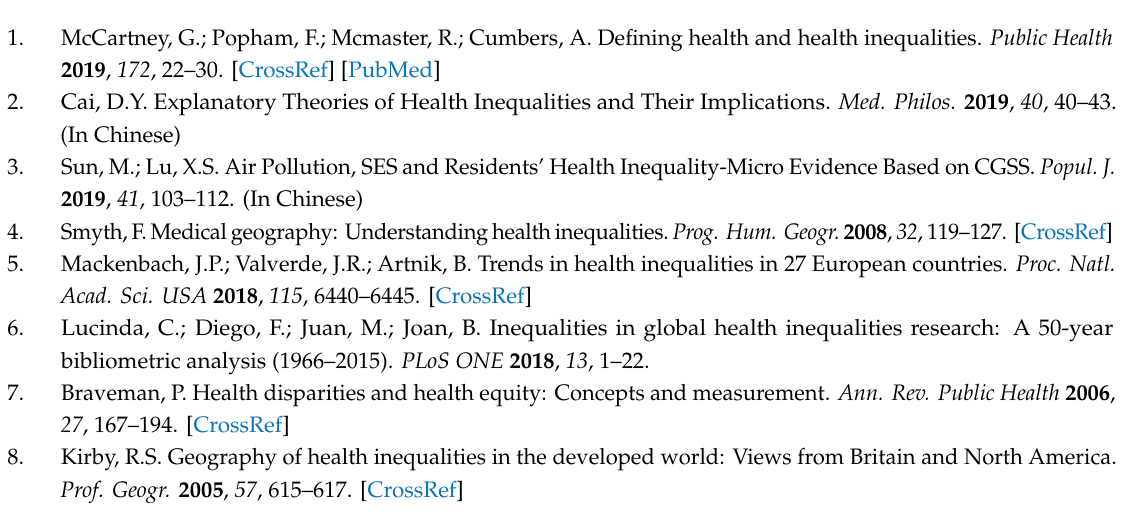
Table S1: The original data of measurement of citizens’health levels; Table S2: The original data of the influencing factors that a ff ect citizens’health